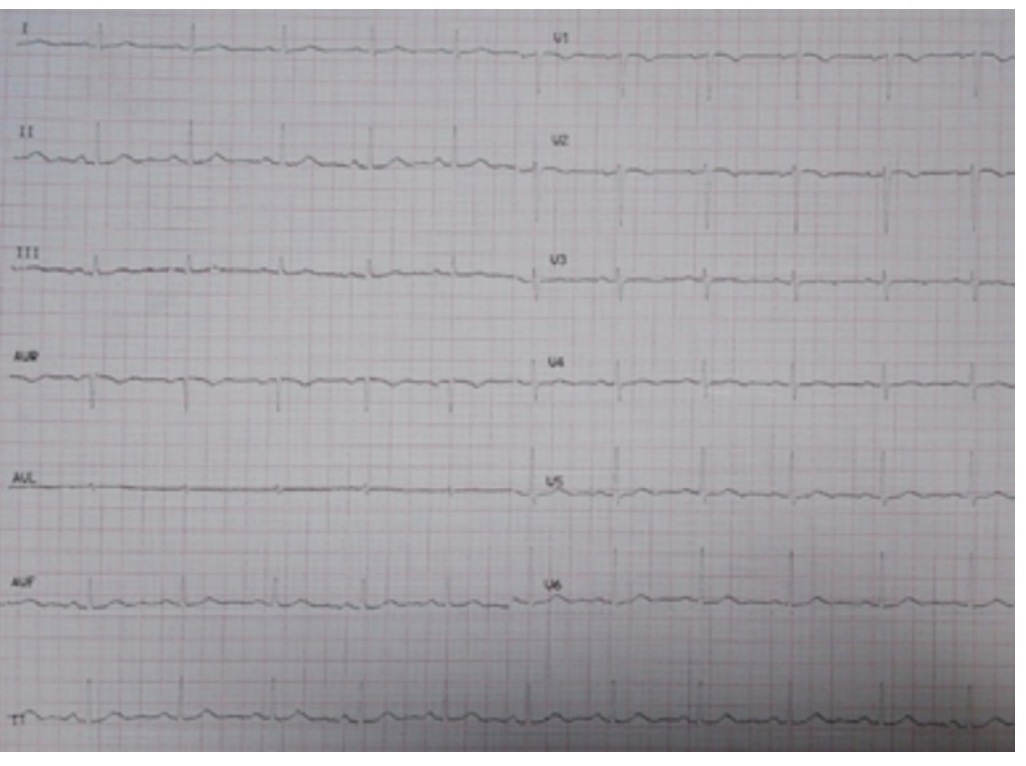
Figure 5. Electrocardiogram patient IV.16. Sinus rhythm, narrow Qrs, with negative T waves V1–V2 and flattened V3.